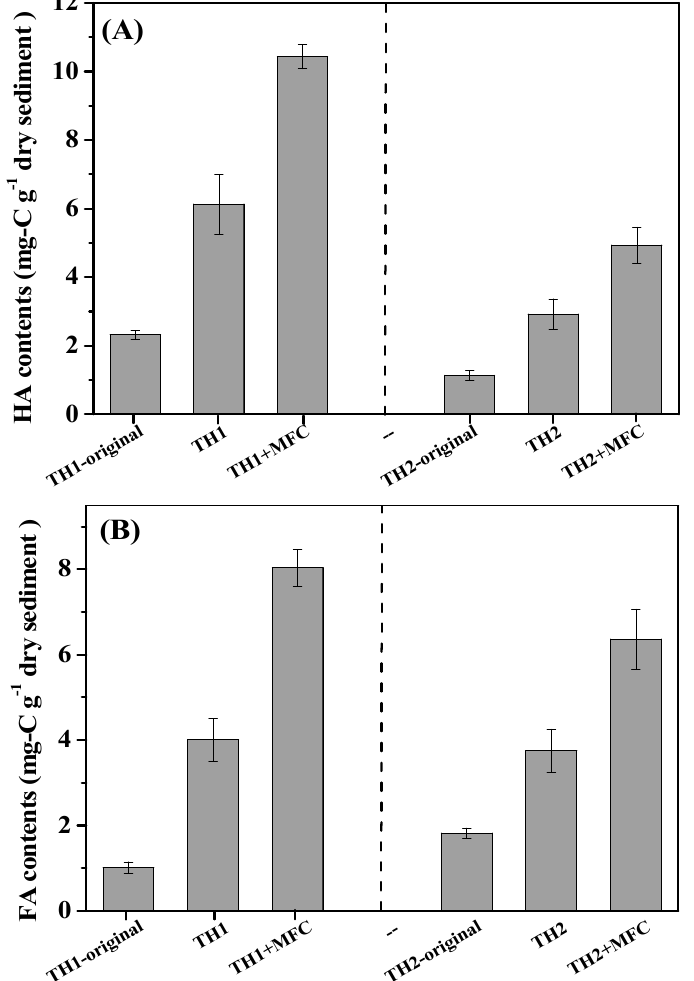
Figure 4. Organic carbon contents of humic acid (HA) ( A ) and FA ( B ) in TH1 and TH2 sediments after 700 days of incubation.